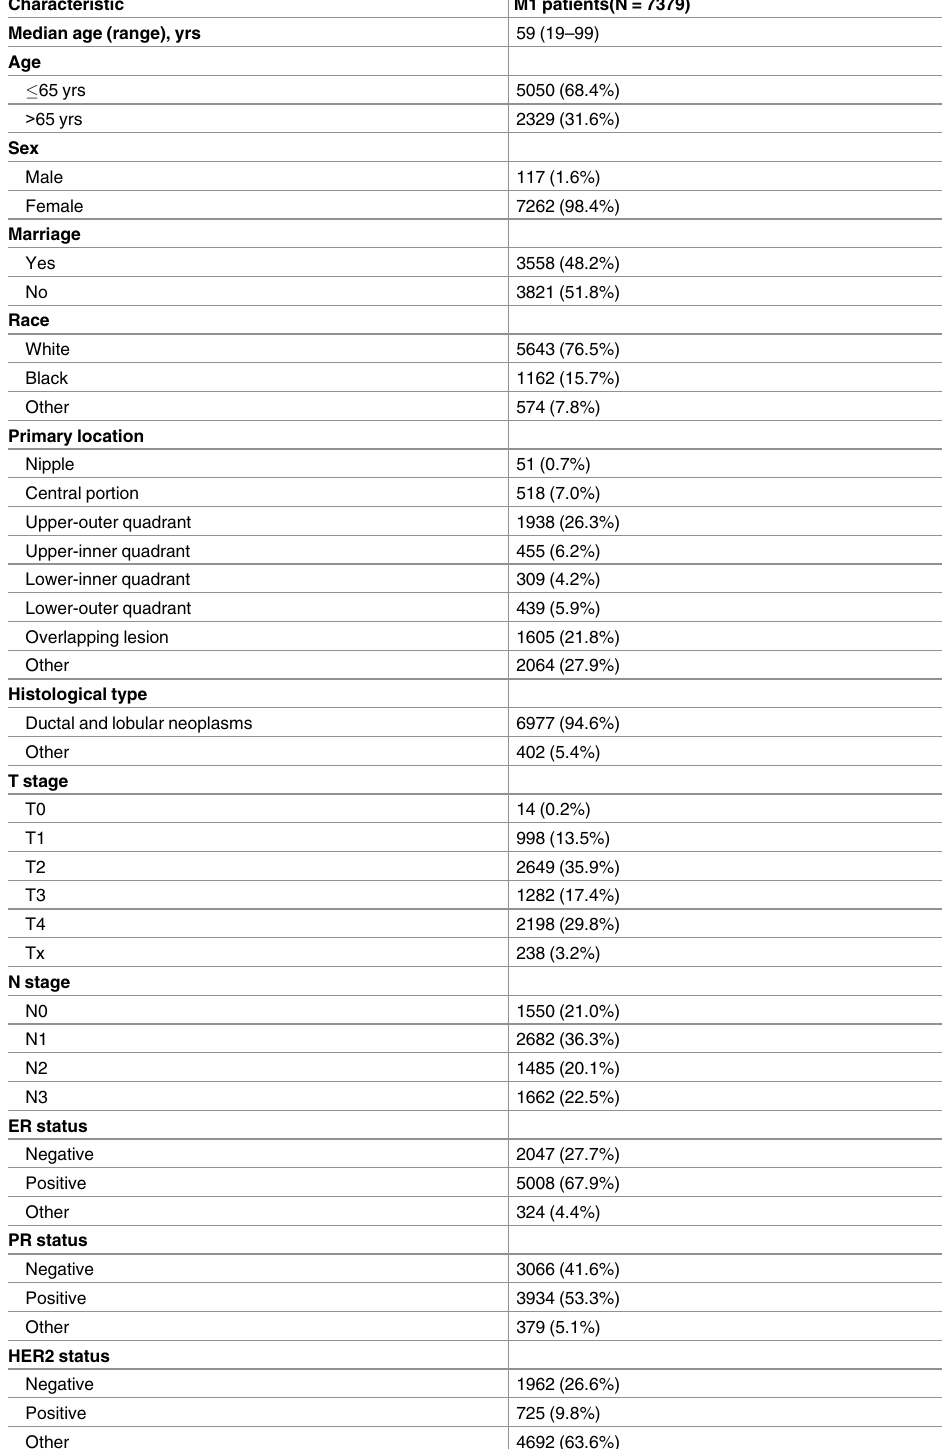
Table 1. Baseline characteristics of patients with breast cancer with M1